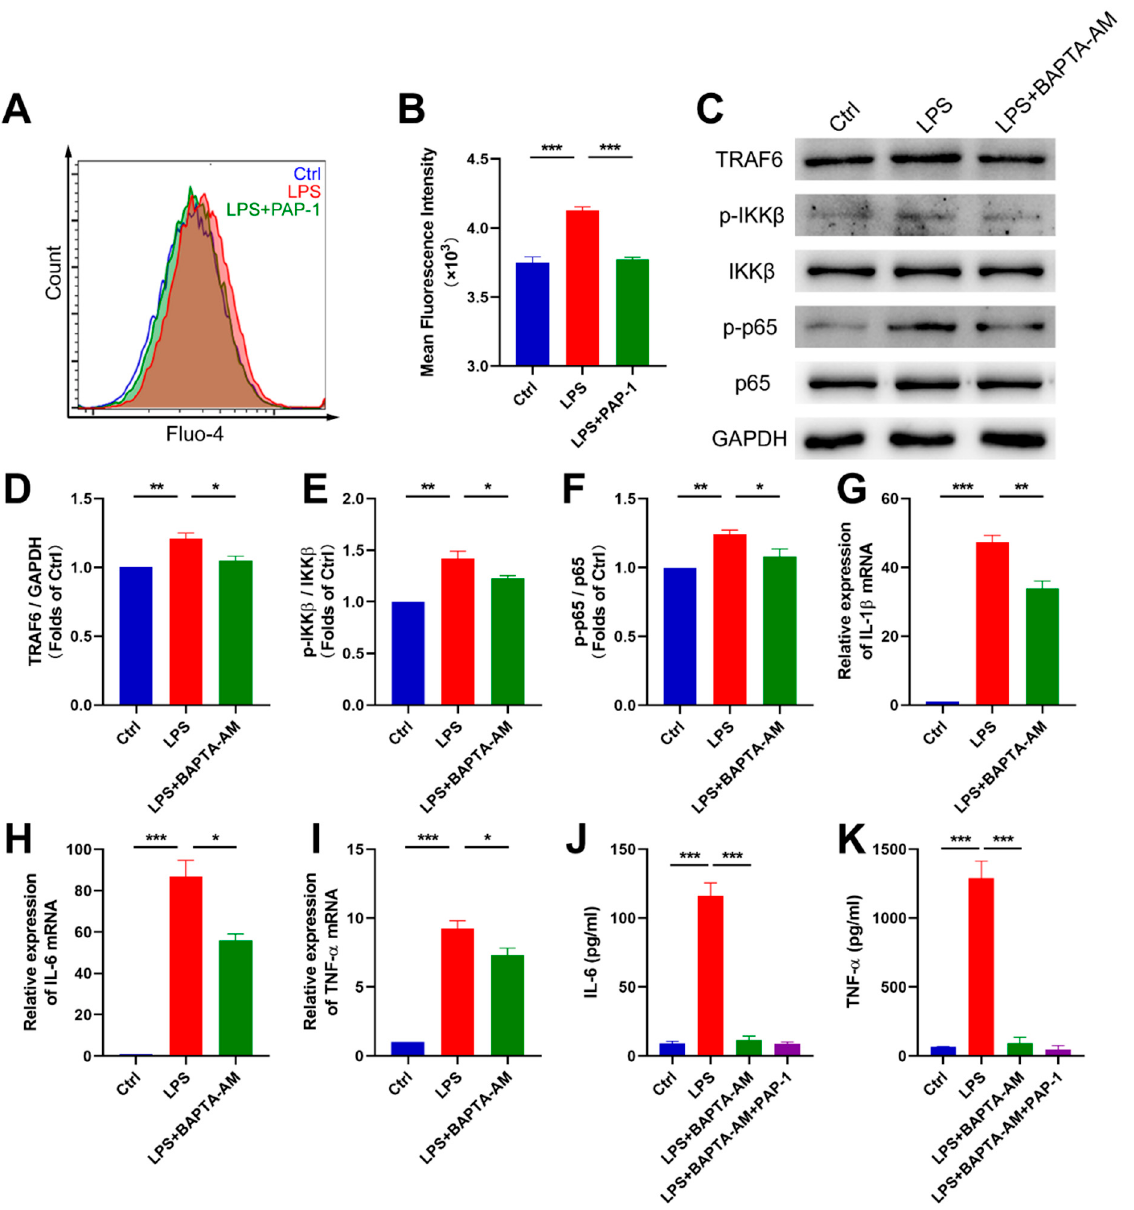
Figure 6. Kv1.3 blockade downregulated the NF- қ B pathway via Ca 2+ signaling. ( A , B ) Flow cytomet- ric analysis of the intracellular Ca 2+ level in BV2 microglia (n = 3); statistics by one-way